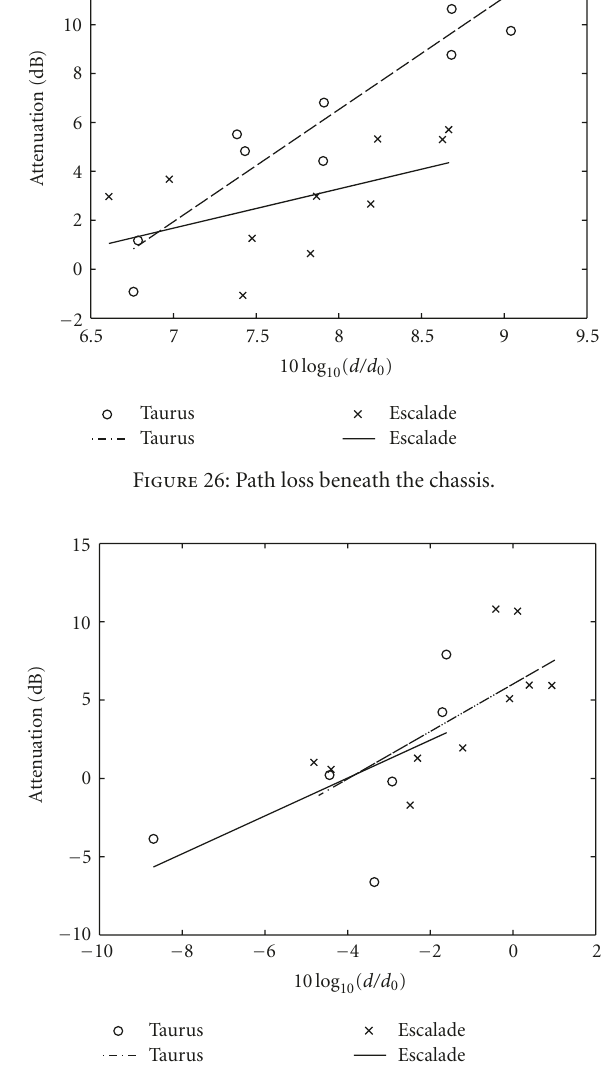
Figure 27: Path loss inside the engine